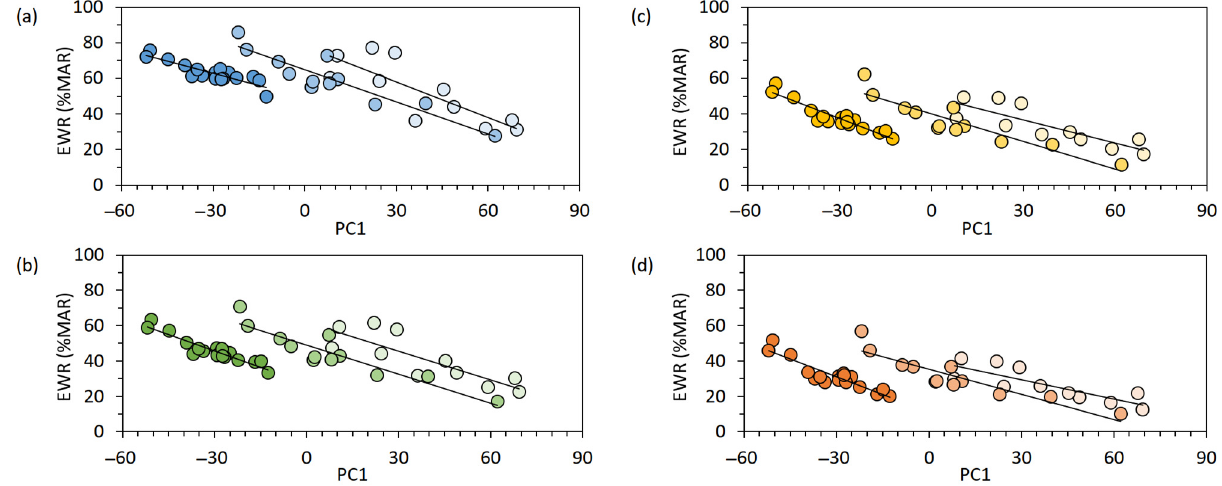
Figure A3. Linear regressions between the principal component 1 eigenvectors (PC1) and the environmental water reserves [expressed as a percentage of the mean annual runoff–EWR (%MAR)] based on the adjustment of the frequency of occurrence per streamflow type (colors gradient: lighter ephemeral, intermediate intermittent and darker perennial). The scatter plots ( a – d ) are displayed according to the environmental objective classes A, B, C, and D in blue, green, yellow, and orange tones, respectively.